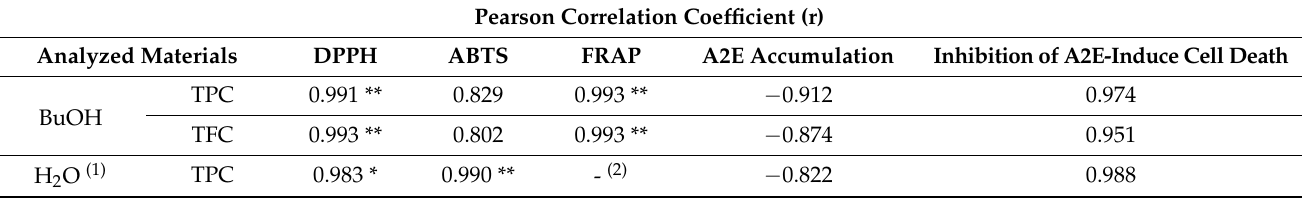
Table 3. Pearson correlation coefficients for TPC, TFC, antioxidant activity, and inhibition of A2E accumulation and A2E-induced cell death of the BuOH and H 2 O